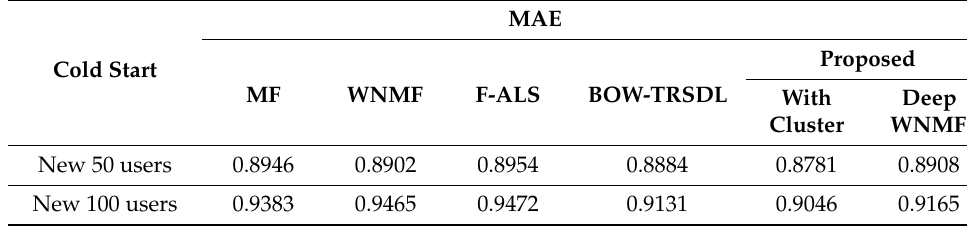
Table 3. Customer cold-start performance.